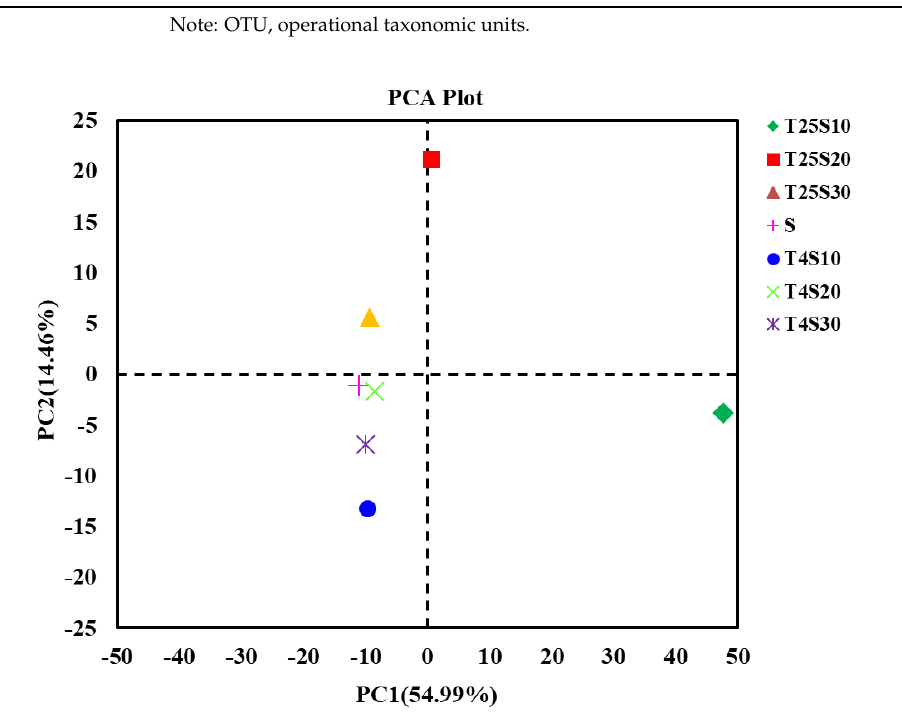
Figure 3. The principal component analysis (PCA) results of the salted kelp samples under different preservation conditions .